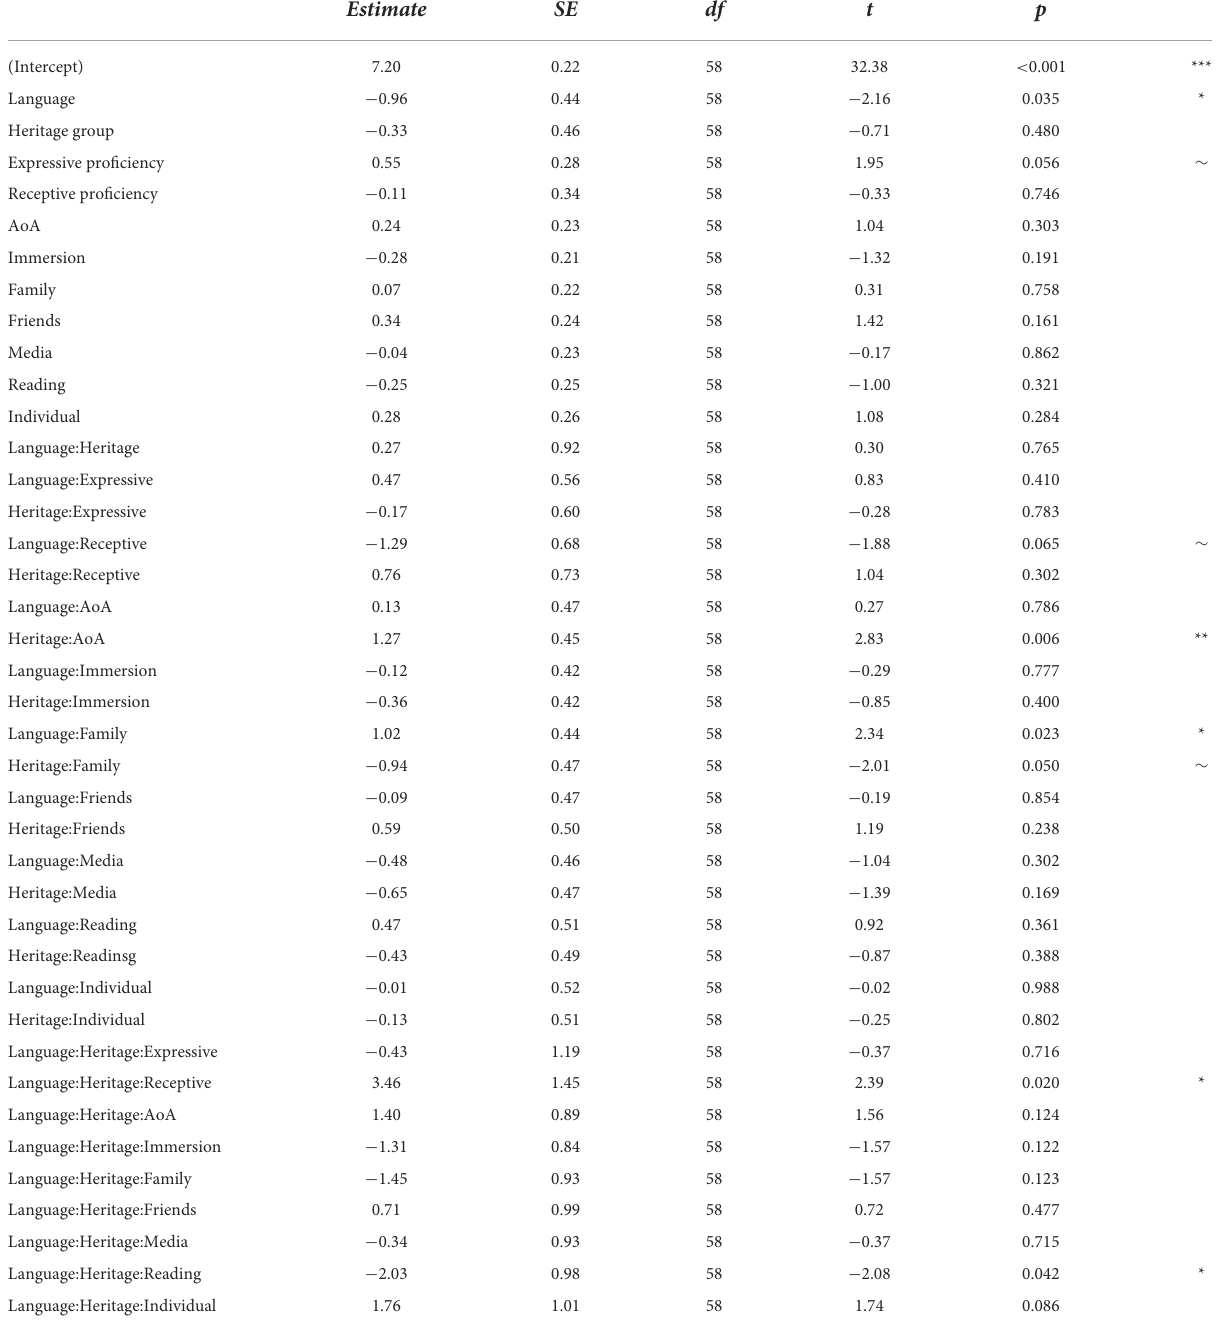
TABLE 5 Effects of heritage language experience on heritage language and English cultural